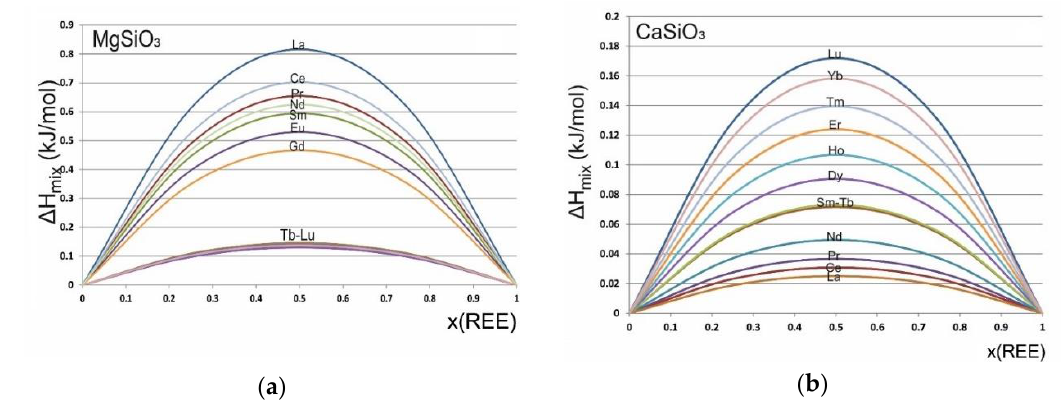
Figure 3. REE partition coefficients for bridgmanite and ringwoodite in the system ringwoodite- mixREE. Sample 3526-1, the pressure is 24 GPa and the temperature is 1600 °C.